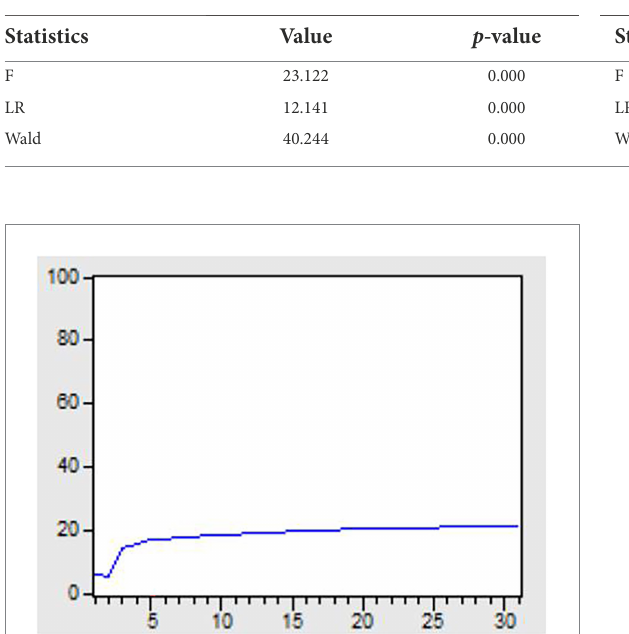
FIGURE 6 Percent EVA variance due to